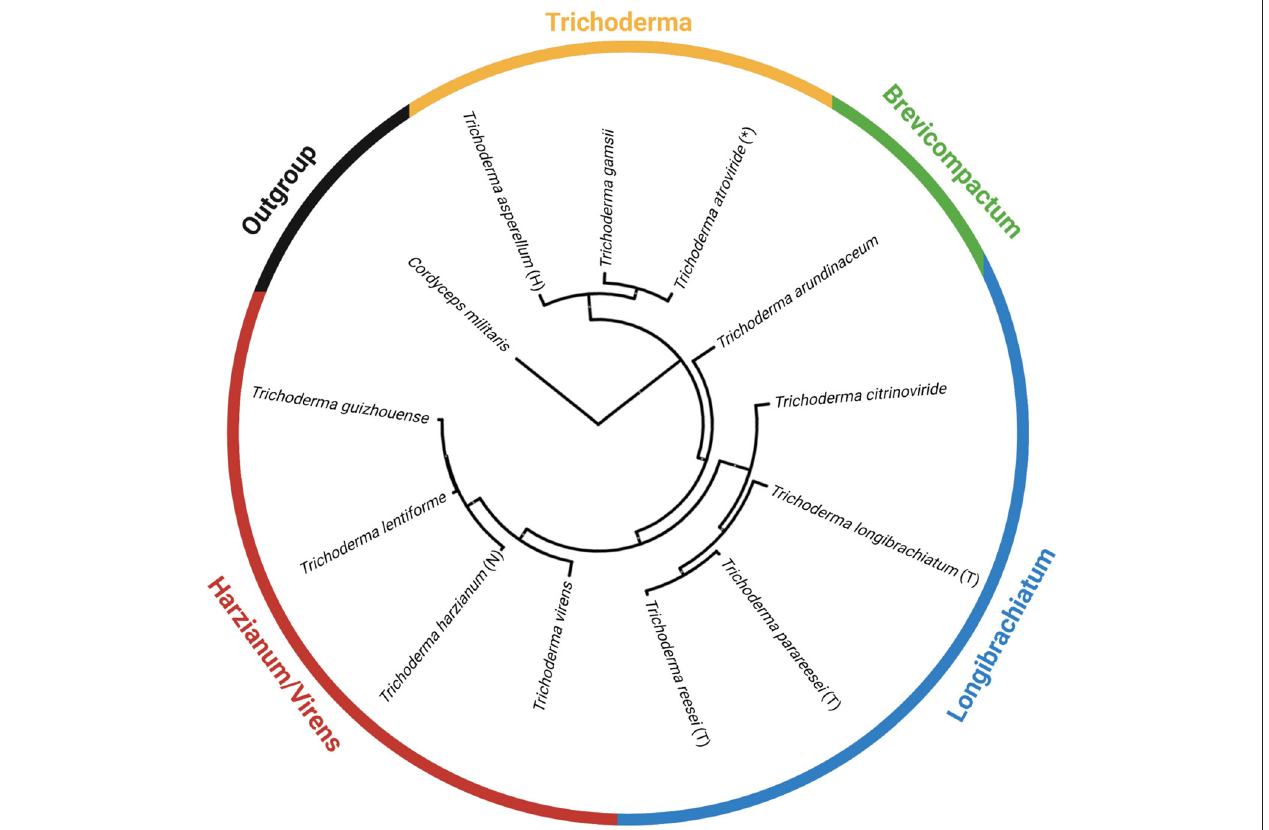
FIGURE 6 | A circular phylogeny of Trichoderma spp. based on genomes available on NCBI as of April 2021. The phylogenetic tree is constructed from the identified orthologous protein groups from each Trichoderma spp. and one outgroup, Cordyceps militaris . The tree was exported and visualized in the interactive Tree of Life—iTOL (https://itol.embl.de/). An asterisk (*) means this strain is used as an active ingredient in commercially available biocontrol products. (T) is the type species; (H) is the holotype; and (N) is the neotype. Data are comparable to the chronogram orthologous protein alignment shown in Kubicek et al. (2019), with T. arundinaceum, a Brevicompactum representative as described in Degenkolb et al.